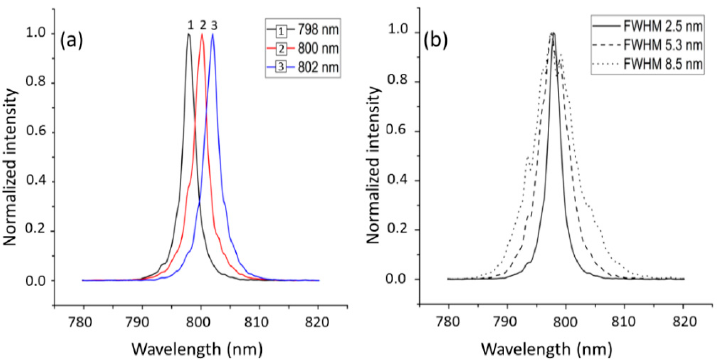
Figure 4. Spectral control by ( a ) tuning the center wavelength via laser mode adjustment (1–3: three states shown with center wavelengths at 798 nm, 800 nm, and 802 nm, respectively), ( b ) varying the FWHM spectral bandwidth ∆ λ for a single selected laser mode (center wavelength λ 0 = 798 nm) between 2.5 nm and 8.5 nm.